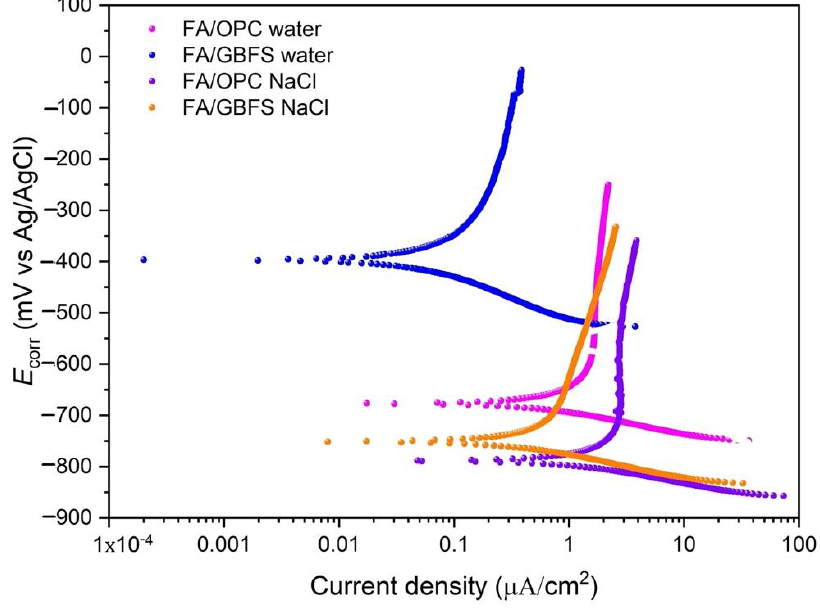
Figure 9. Polarization curves of AACs at 360 days of exposure in water and NaCl environments.